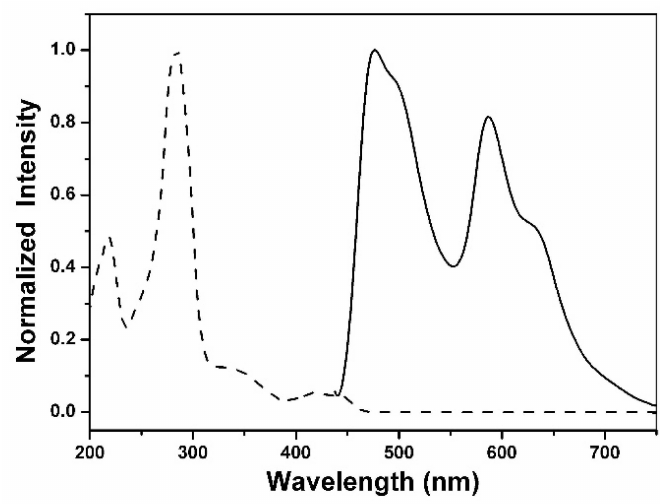
Figure 5. Normalized absorption (dashed line) and emission (solid line) spectra of 1 in ethyl